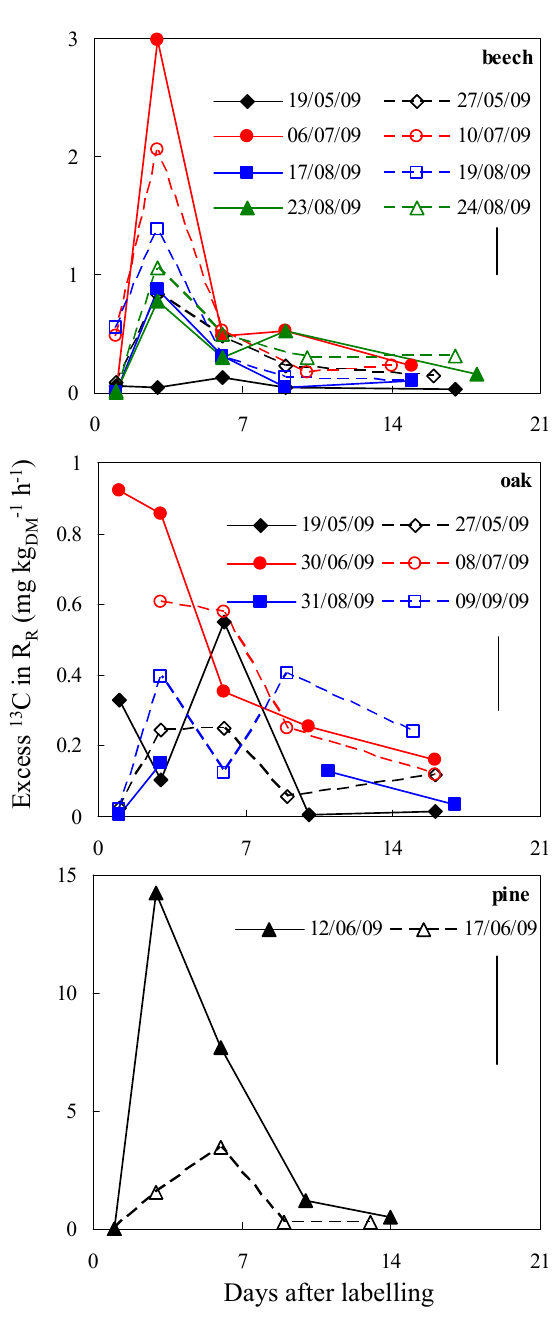
Fig. 4. Time courses of Excess 13 C in root respiration ( R R ) after whole crown pulse labelling of beeches (top), oaks (middle) and pines (bottom). Each tree is identified by its date of labelling. There are significant differences between trees for beech ( F 7 , 42 = 4 . 1, p < 0 . 01) and oak ( F 5 , 15 = 3 . 0, p < 0 . 05) and between sampling dates for beech ( F 32 , 42 = 4 . 7, p < 0 . 001). The verticals bars represent the root mean